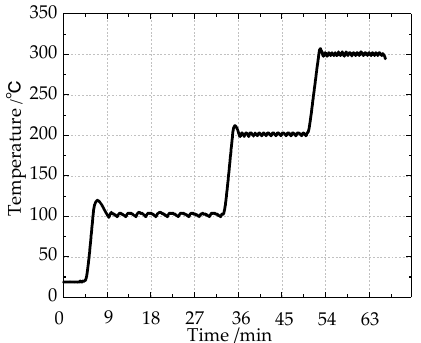
Figure 8. Relationship between heating temperature and time of pipeline. The excitation point was located in the center of the pipeline, and the measuring point was arranged on the rigid transfer plate connected with the gantry on one side of the pipeline. The arrangement of the measuring point and the excitation point is shown in Figure 9.